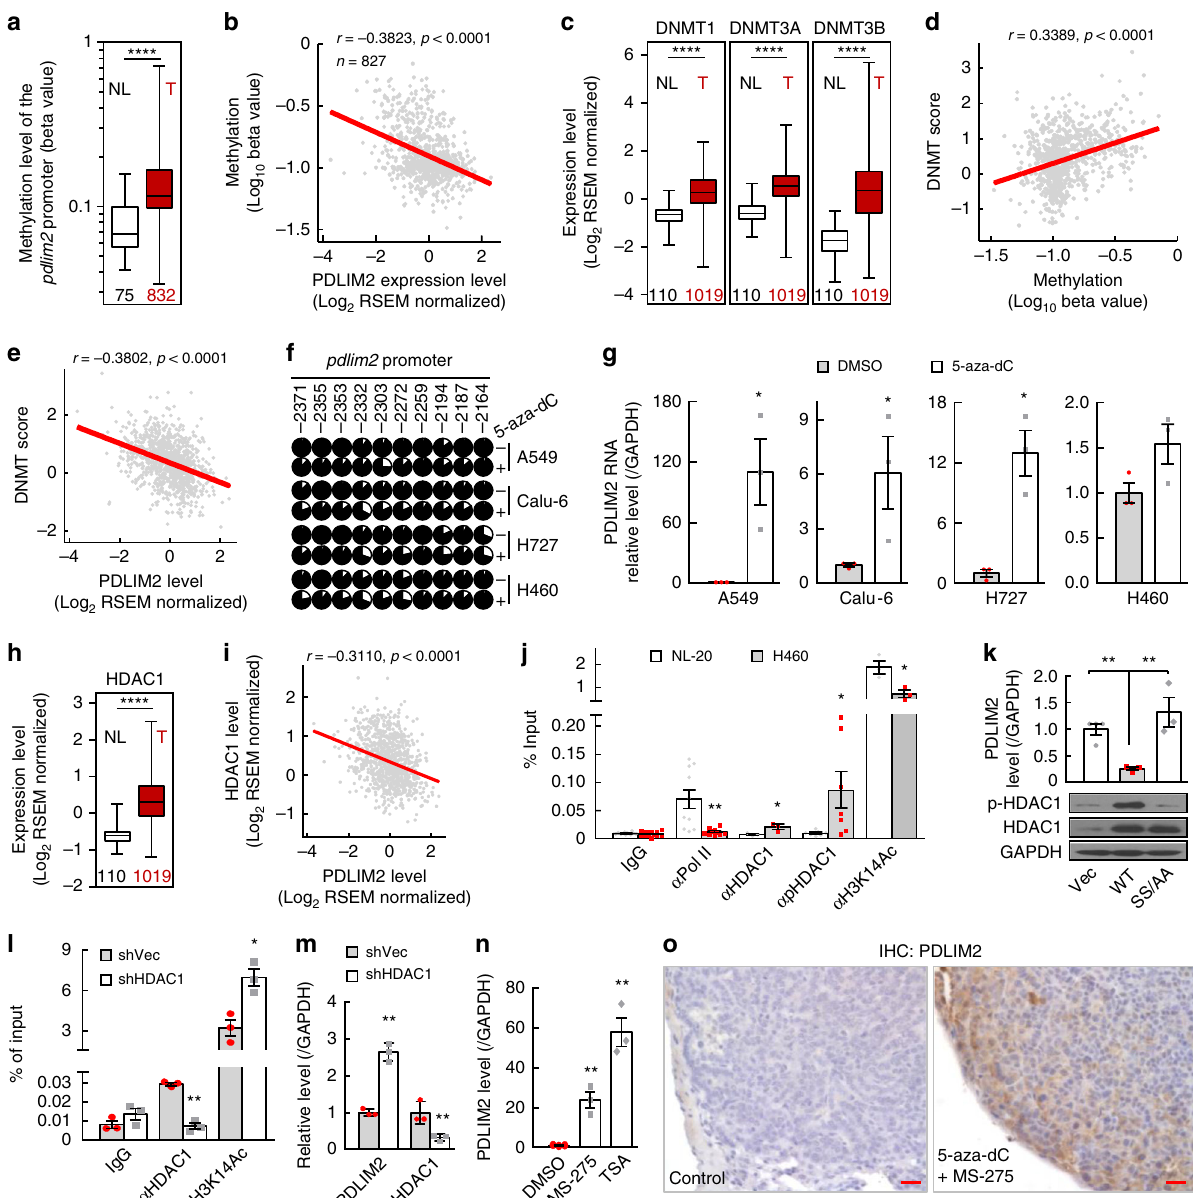
Fig. 2 PDLIM2 repression in lung cancer involves promoter DNA methylation by DNMTs and promoter histone deacetylation by HDACs. a – e TCGA data showing increased pdlim2 promoter methylation ( a ), negative association between PDLIM2 expression and its promoter methylation ( b ), increased DNMT expression ( c ), positive association between DNMT expression and pdlim2 promoter methylation ( d ), and negative association between DNMT and PDLIM2 expression ( e ) in human lung cancer. T, tumors; NL, normal lungs. f Bisul fi te genomic DNA sequencing showing 5-aza-dC de-methylation of the pdlim2 promoter in the indicated human lung cancer cell lines. Each circle represents a CpG site. Ratio of the fi lled area represents the methylation percentile. The position of each CpG nucleotide relative to the PDLIM2 transcription initiation site ( + 1) is indicated at the top. g qPCR analysis showing PDLIM2 induction by 5-aza-dC in the indicated human lung cancer cell lines ( n = 3). h , i TCGA data showing increased HDAC1 expression ( h ), and negative association between HDAC1 and PDLIM2 expression ( i ) in human lung cancer. j Chromatin immunoprecipitation (ChIP) showing increased HDAC1 and p-HDAC1 but decreased Pol II and H3K14Ac at the pdlim2 promoter in H460 human lung cancer cells ( n ≥ 3). k qPCR showing PDLIM2 down- promoter by HDAC1 knockdown in H460 cells ( n ≥ 3). m , n qPCR showing PDLIM2 up-regulation by HDAC1 knockdown or MS-275/TSA treatment in the columns, and the bottom-most and topmost horizontal lines, the lower and upper hinges, and the middle line of the boxplots indicate the minimum and maximum values, the 25th and 75th percentiles, and the median, respectively, in ( a , c , h ). Student ’ s t test (two tailed, unpaired) was performed in ( a , c , g , h , j - n ). Data represent means ± SEM in ( g , j – n ). * P < 0.05; ** P < 0.01; *** P < 0.001; **** P <